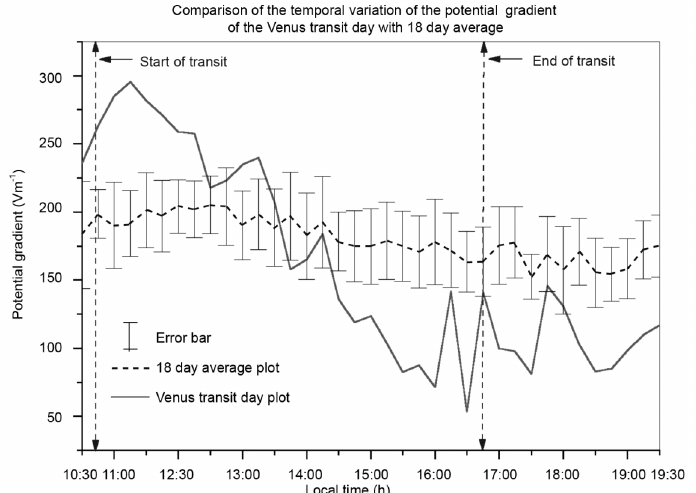
Fig. 3. Variation of atmospheric vertical potential gradient on the day of Venus transit, 8th June 2004 (contin- uous line) and average variation of the same parameter around 8th June for 18 days (dotted